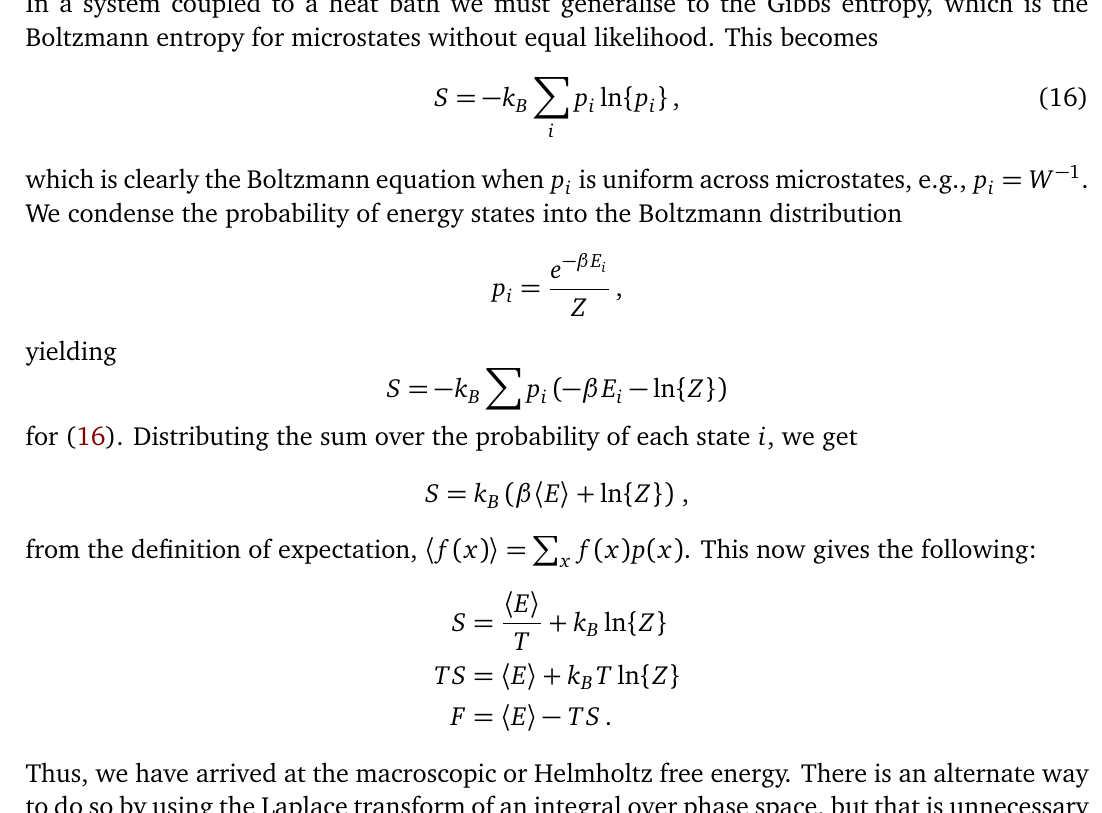
Figure 2: Plotting magnetisation for temperature using self-consistency. The surface in grey is y = m and the blue surface is f ( T , m ) = tanh of points where f ( T , m ) = m , necessarily given by their intersection, is in the subspace ( T , m ( T )) . Indeed, the black curve is the well-known plot of the mean field magnetisation function. An interactive version of this figure can be found at https://www.geogebra.org/m/cjgaepxq